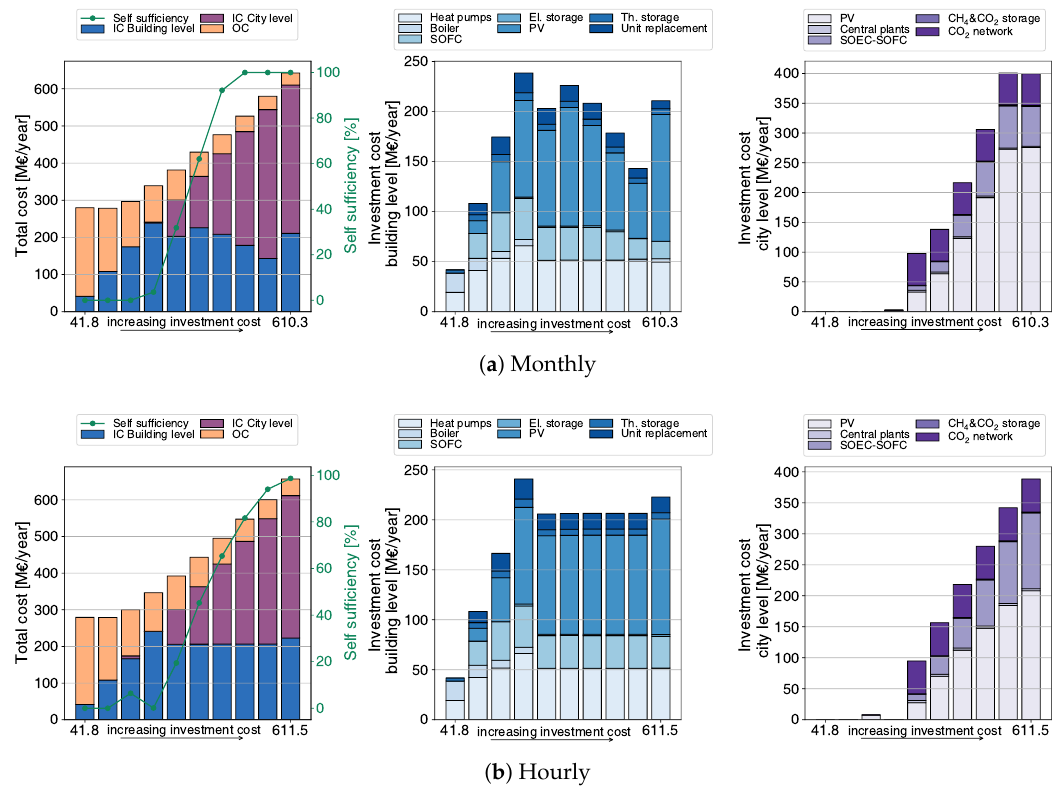
Figure 14. Geneva city center cost breakdown for different time